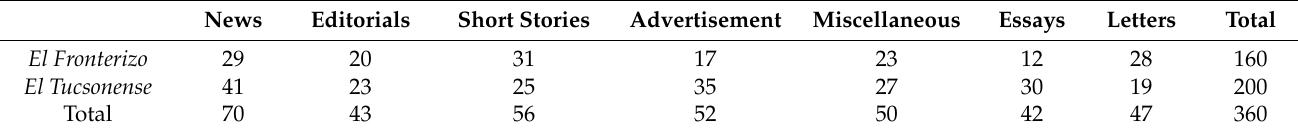
Table 2. Articles analyzed for each newspaper by journalistic